Question: Identify the chart type used in this figure.
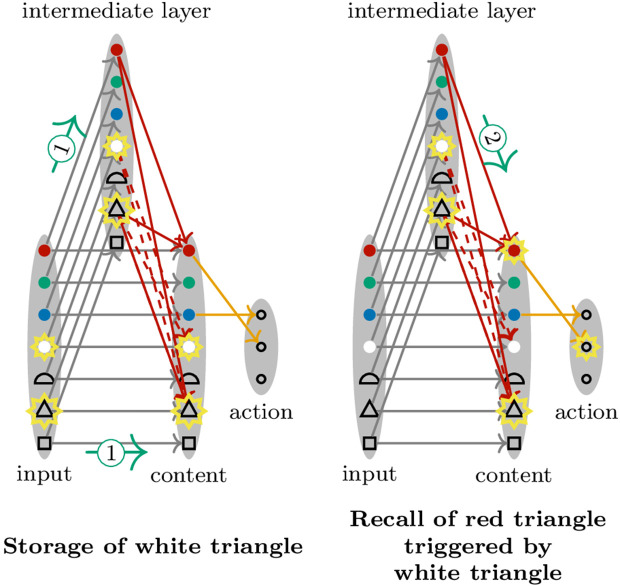
Answer: line